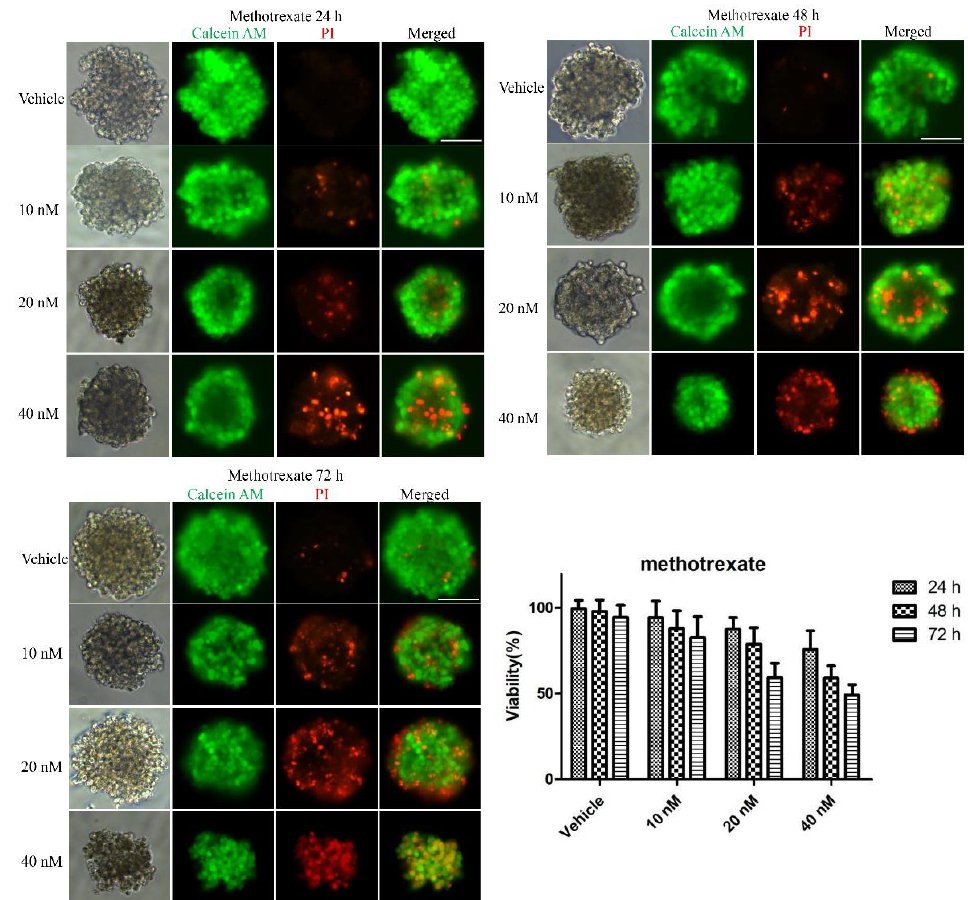
Figure 7. Drug assay (methotrexate) on tumor spheroids: live/dead cell assay images stained with Calcein AM (green) for viable cells or PI (red) for dead cells. Cell viability decreased over time and concentration. The histogram shows the cell survival rate of the indicated concentrations after 24 h, 48 h and 72 h of the methotrexate administration (the data are presented as mean ± SD). Magnification = 20 × , Bar = 75 µ m.